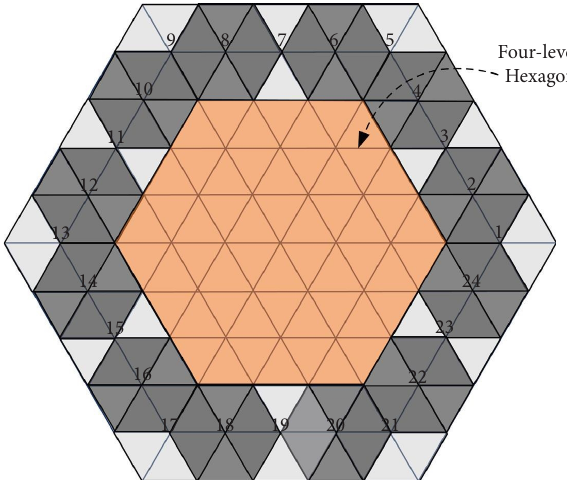
Table 2: Selection of 6L hexagons from 11L